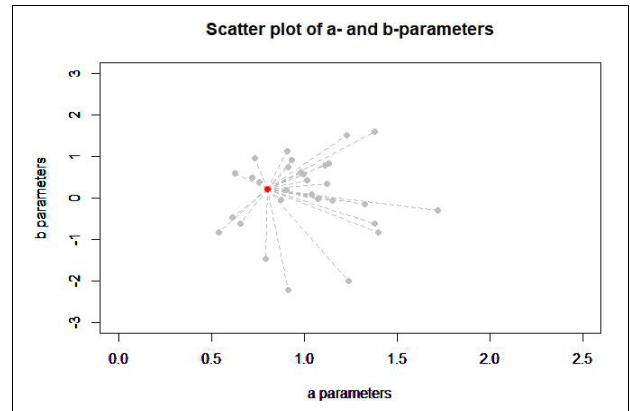
FIGURE 2 | Scatter plot of a - and b